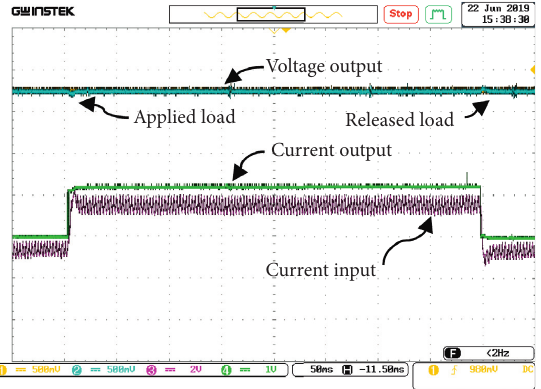
Figure 22: Result of maintaining voltage stability and current while changing load using a PI controller with TS search.